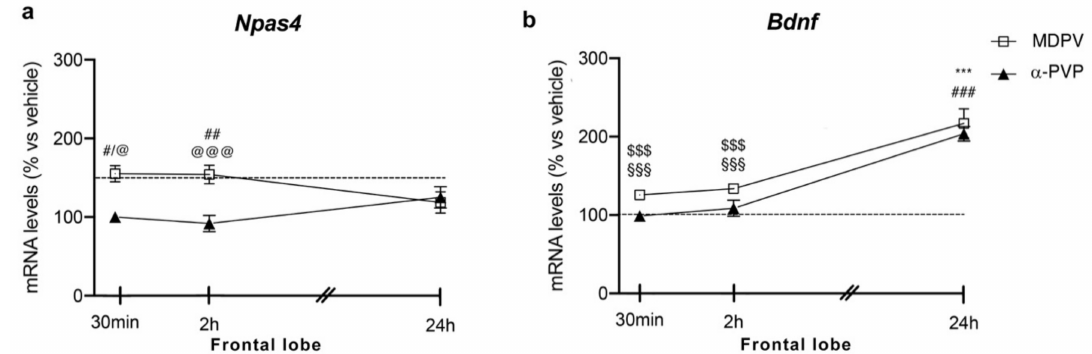
Figure 2. Time-dependent changes in Npas4 ( a ) and Bdnf ( b ) mRNA levels in the frontal lobe of mice following a single IP injection of MDPV (1 mg/kg) or α -PVP (1 mg/kg). Mice were sacrificed at three different time points, i.e., 30 min, 2 h, and 24 h after the drug administration. Results are expressed as percentages relative to vehicle-treated group and presented as mean ± standard error of the mean (SEM). *** p < 0.001 α -PVP versus vehicle-treated mice; # p < 0.05, ## p < 0.01, ### p < 0.001 MDPV versus vehicle-treated mice; $$$ p < 0.001 MDPV versus MDPV-24 h; @ p < 0.05, @@@ p < 0.001 MDPV versus α -PVP; §§§ p < 0.001 α -PVP versus α -PVP-24 h (two-way ANOVA followed by Tukey’s multiple comparisons